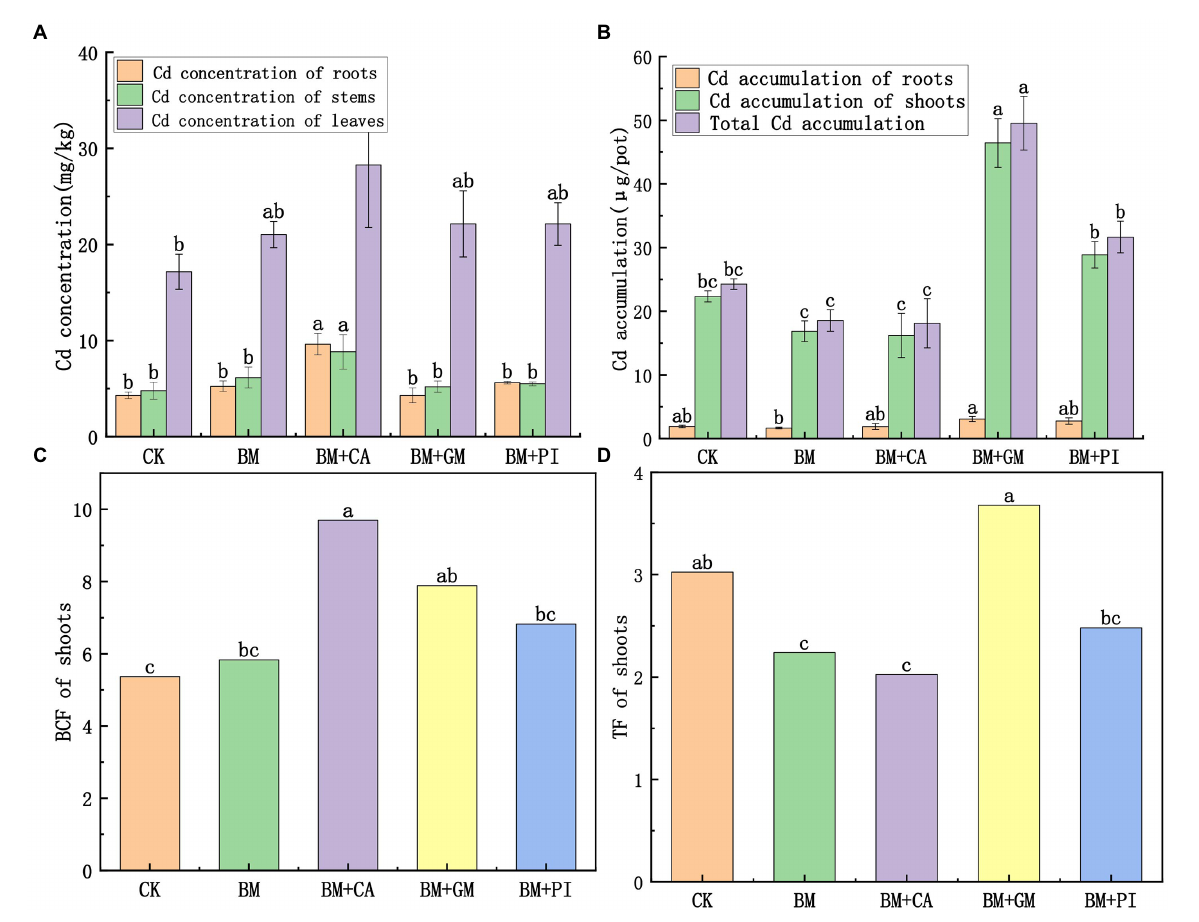
FIGURE 1 The effects of different treatments ( S . nigrum (CK), Bacillus megaterium (BM) along with citric acid (BM + CA), Glomus mosseae (BM + GM), and Piriformospora indica (BM + PI)) on the Cd concentrations (A) and accumulation of Cd (B) in S . nigrum . Variation in BCF and TF of the shoots of S . nigrum in different treatments (C,D) . Error bars show the standard deviation of triplicate samples, and columns with different letters are significantly different according to one-way ANOVA, followed by Duncan’s test ( p < 0.05).